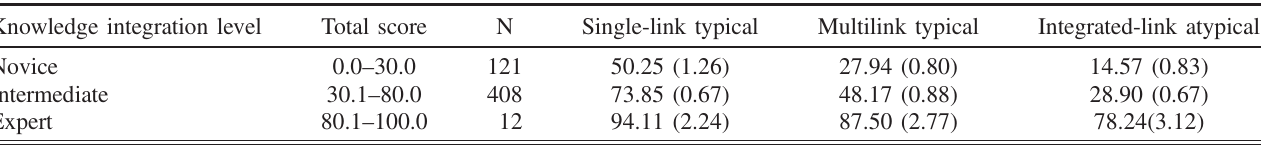
TABLE III. Summary of total score and question set scores per knowledge integration level based on combined pre- and post-test data. Standard errors are given in